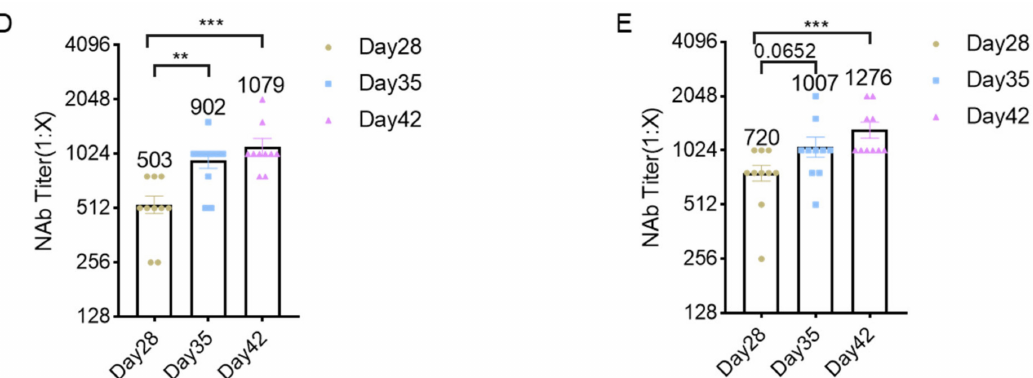
Figure 1. Analysis of neutralizing antibody levels of different inactivated vaccines. ( A ) Experiment schematic—the BALB/c mice were injected with different vaccines on day 0 and day 21, and the blood was collected on day 28/35/42 after the first immunization. The serum from day 28/35/42 was used for the neutralization assay; additionally, the serum from day 42 was analyzed via metabolic and proteomic analysis. Additionally, the spleens collected on day 42 after immunization were used in flow cytometry and ELISPOT. ( B ) The GMT levels of the HB02, Delta, and Omicron vaccines against their respective strains on day 28/35/42 after immunization; ( C ) the NAb titer of HB02 vaccine against the HB02 strain on day 28/35/42 after immunization; ( D ) the NAb titer of Delta vaccine against the Delta strain on day 28/35/42 after immunization; ( E ) the NAb titer of Omicron vaccine against the Omicron strain on day 28/35/42 after immunization; error bars represent SEM. ** p < 0.01; *** p < 0.001 (( B – D ), Mann–Whitney test).